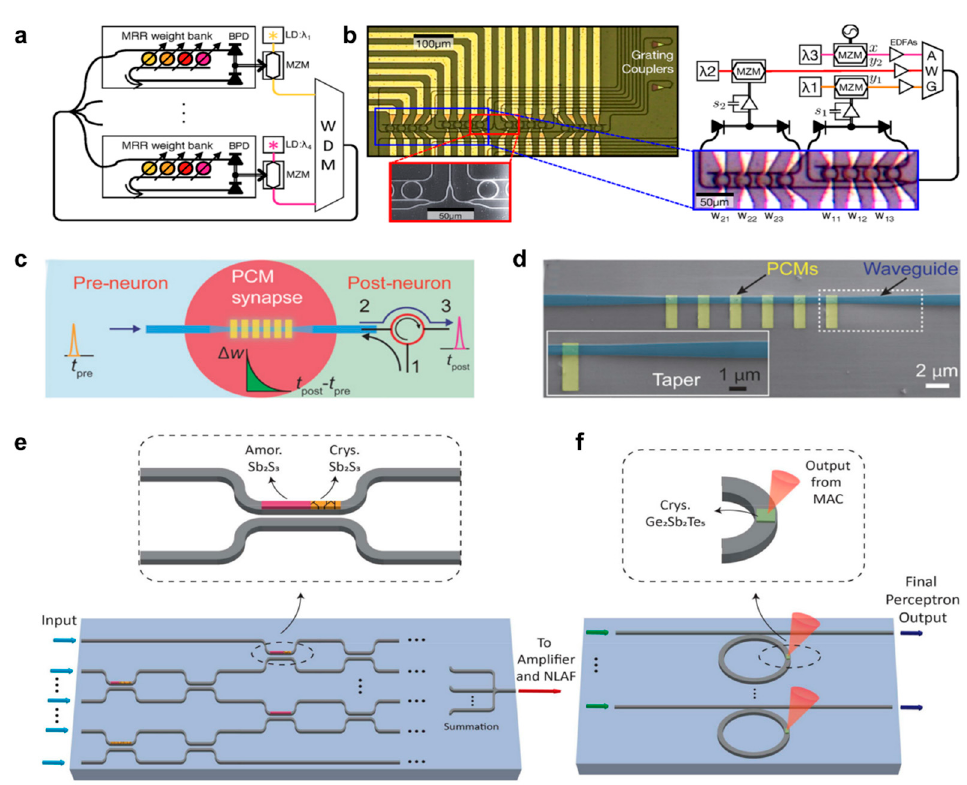
Figure 1. Weighting function in ONNs. ( a ) Concept of a broadcast-and-weight network with modulators used as neurons. MRR: microring resonator, BPD: balanced photodiode, LD: laser diode, MZM: Mach–Zehnder modulator, WDM: wavelength-division multiplexer [10]. ( b ) Micrograph of 4-node recurrent broadcast-and-weight network with 16 tunable microring (MRR) weights and fiber-to-chip grating couplers [10]. ( c ) Schematic of the integrated photonic synapse resembling the function of the neural synapse [12]. ( d ) Scanning electron microscope image of the active region of the photonic synapse [12]. ( e ) The weighting and summation mechanisms are based on a cascade of Sb 2 S 3 -SiN hybrid photonic switches that serve the same function as an optical counterpart of an FPGA (Field Programmable Gate Array) [13]. ( f ) The NLAF (Non-linear Activation Function) module consists of a single-mode hybrid silicon waveguide [13]. ( a , b ) Adapted with permission from Ref [10]. CC BY 4.0. ( c , d ) Adapted with permission from Ref [12]. CC BY 4.0. ( e , f ) Adapted with permission from Ref [12] CC BY 4.0.